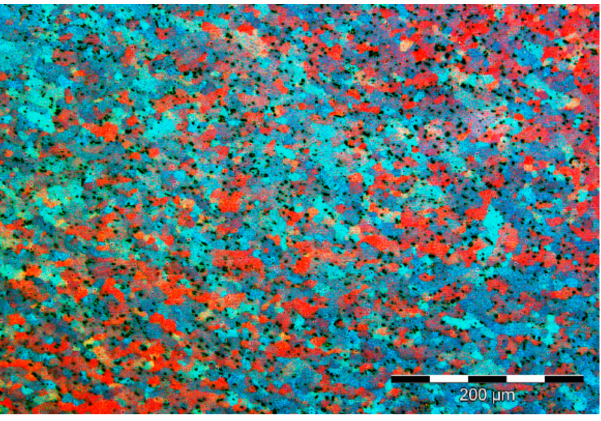
Figure 1. Initial microstructure of the EN-AW-6082 specimens